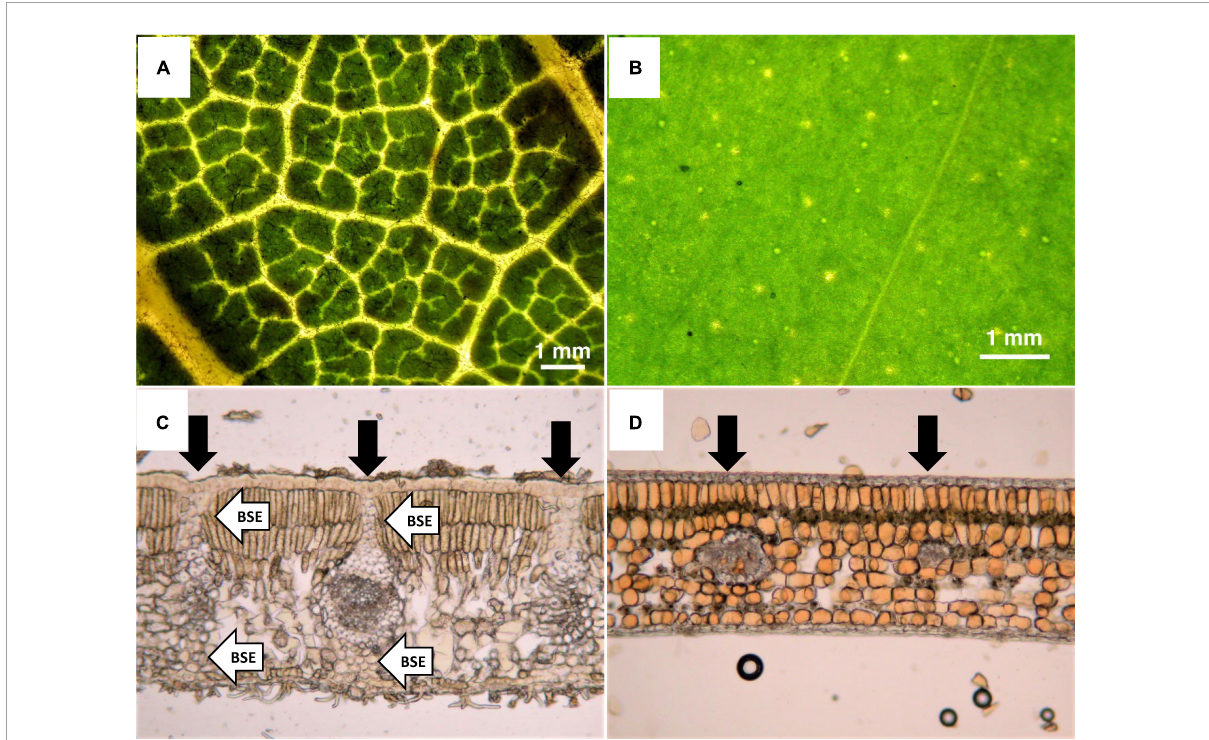
FIGURE1 Photographs of leaf surfaces (upper panels) and transverse sections of leaves (lower panels). (A) Heterobaric leaf from the canopy ( Dacryodes incurvata ), (B) homobaric leaf from the subcanopy ( Syzygium griffithii ), (C) heterobaric leaf from the canopy ( Lithocarpus luteus ), and (D) homobaric leaf from the understory ( Dimorphocalyx denticulatus ). Black arrows in the lower panels indicate the positions of vascular bundles, and white arrows indicate BSEs. Due to the absence of chloroplasts in BSEs, the light penetrates the leaf, and thus the vein network is clearly visible in heterobaric leaves (A) , but not in homobaric leaves (B)